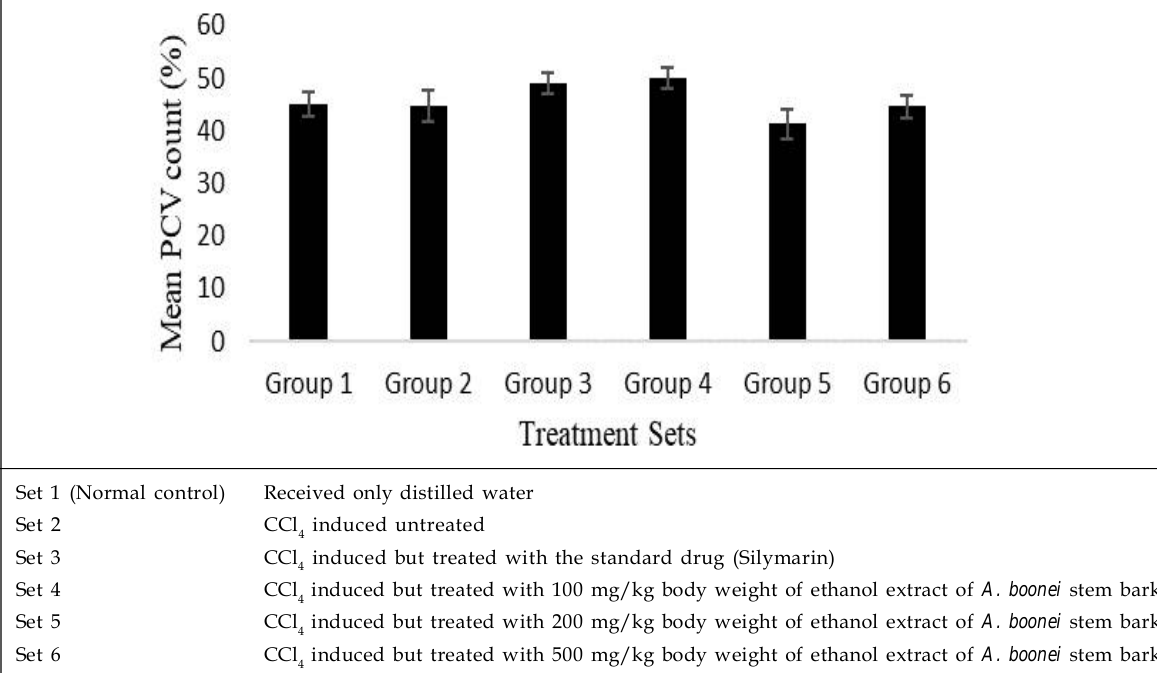
Figure 5: PCV count of carbon tetrachloride (CCl stem bark extract